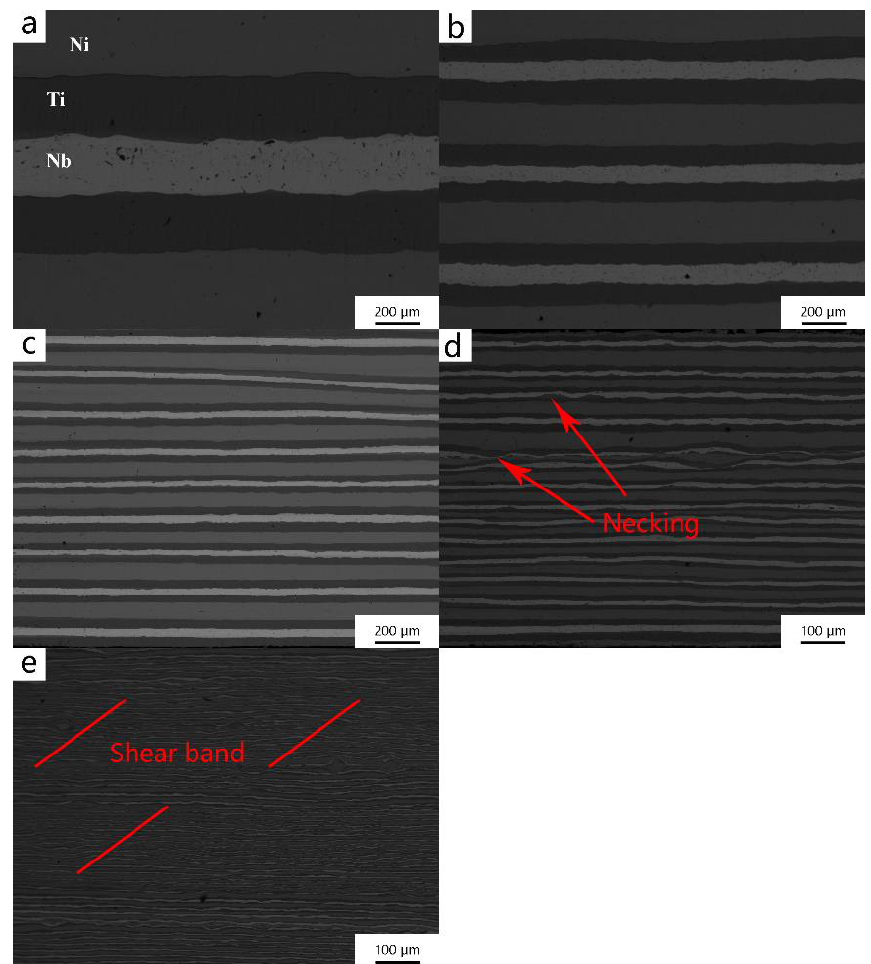
Figure 3. SEM micrographs of the Ni/Ti/Nb composite: ( a ) after the first pass, ( b ) after the second pass, ( c ) after the third pass, (d) after the fourth pass, and ( e ) after the fifth pass. ( c ) after the third pass, ( d ) after the fourth pass, and ( e ) after the fifth